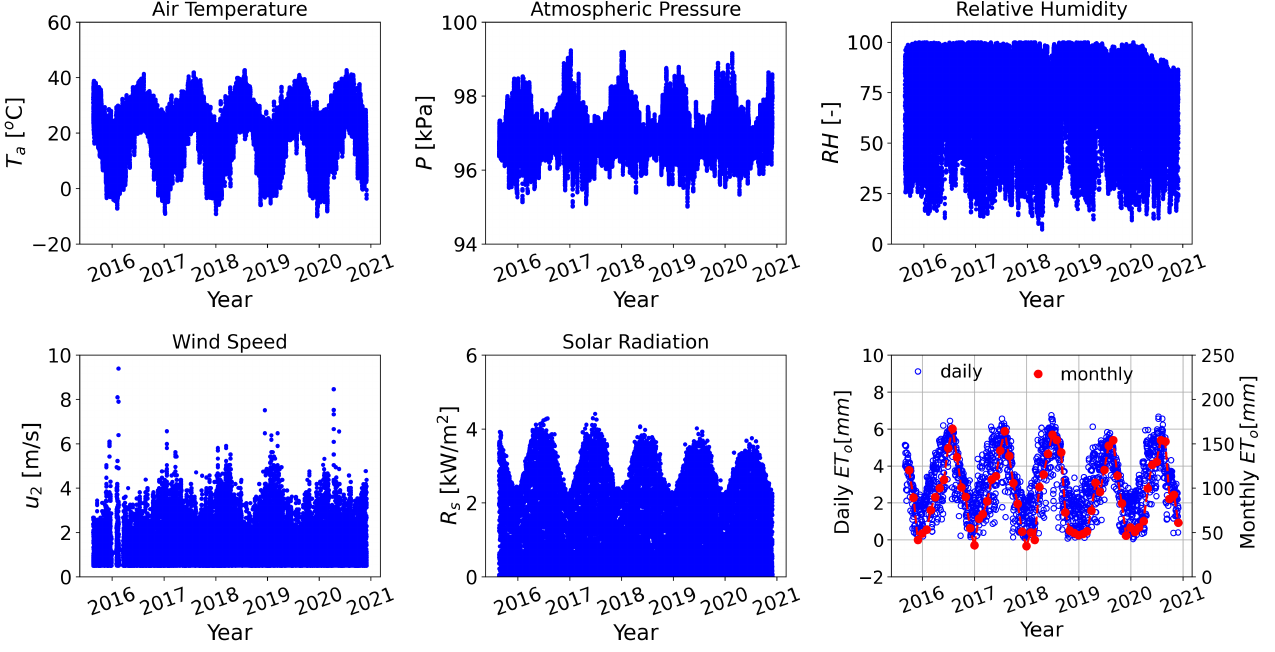
Figure A1. Hourly climate data and FAO56 PME-computed ET o at the NDR weather